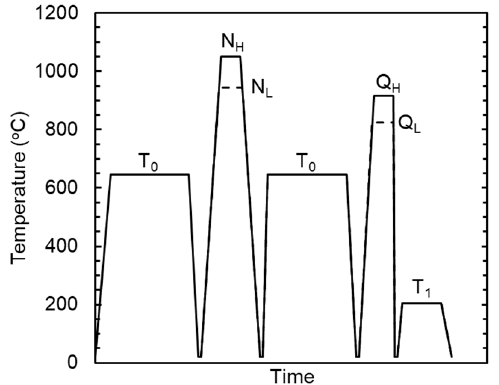
Figure 2. Schematic diagram of the heat treatments applied to the alloy investigated.